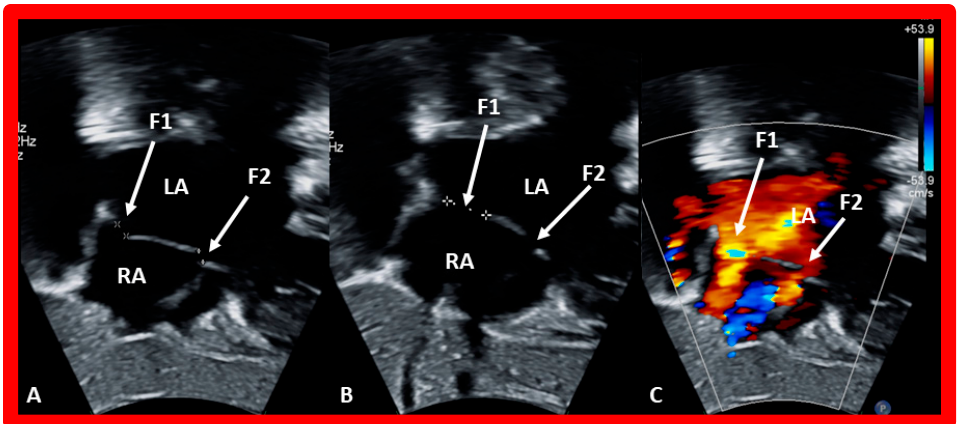
Figure 6. Echo images from subcostal long-axis views of an atrial septum illustrating fenestrated atrial septal defect. Fenestration 1 (F1) ( A ) is much larger and is a somewhat different projection of the atrial septum ( B ). Left-to-right shunts across both fenestrations is shown in ( C ). F2, fenestration 2; LA, left atrium; RA, right atrium.